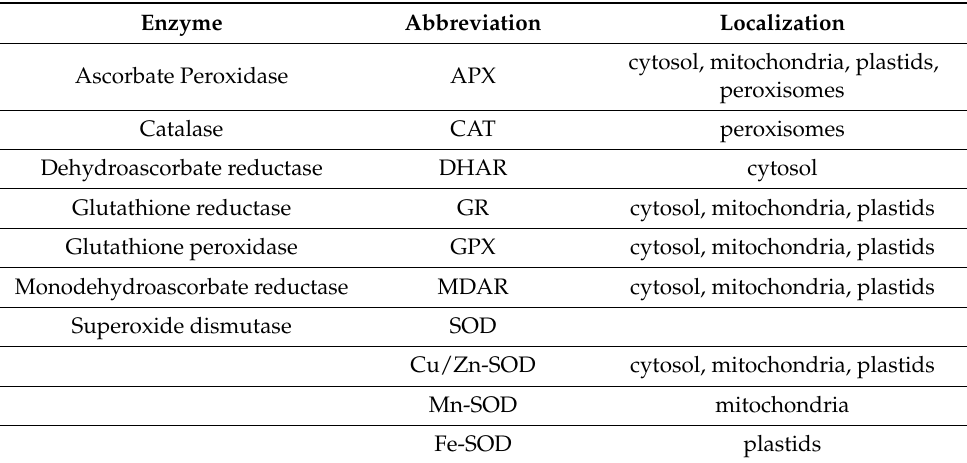
Table 1. Subcellular localization of major antioxidant enzymes in